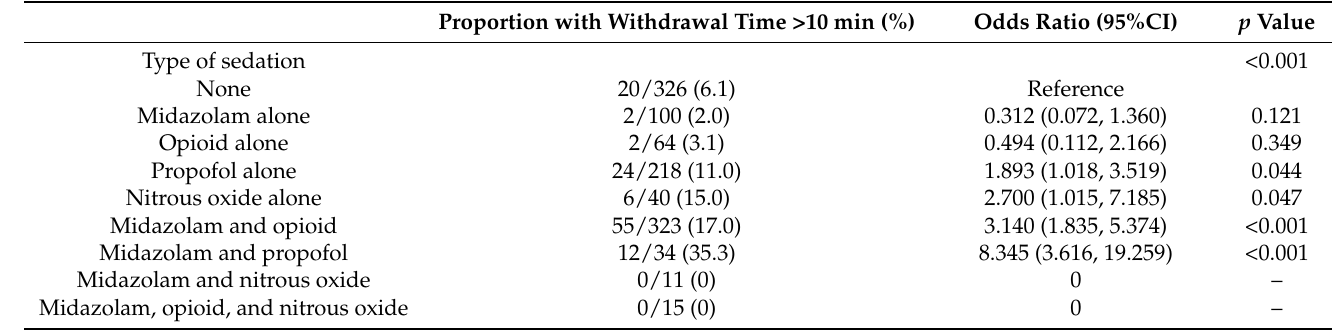
Table 3. Proportion of procedures with a withdrawal time greater than 10 min according to type of sedation (combinations with a frequency <10 were excluded from